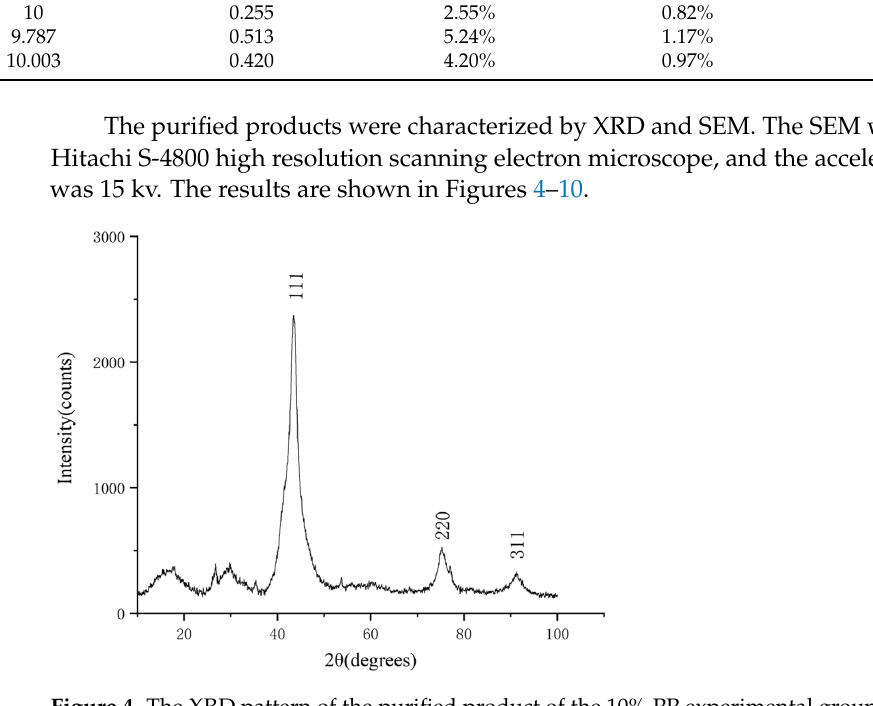
Figure 6. The XRD pattern of the purified product of the 10% PE experimental group. The horizontal coordinate indicates the diffraction angle and the vertical coordinate indicates the intensity of the diffraction peaks. The crystal planes corresponding to the three diffraction peaks are indicated.